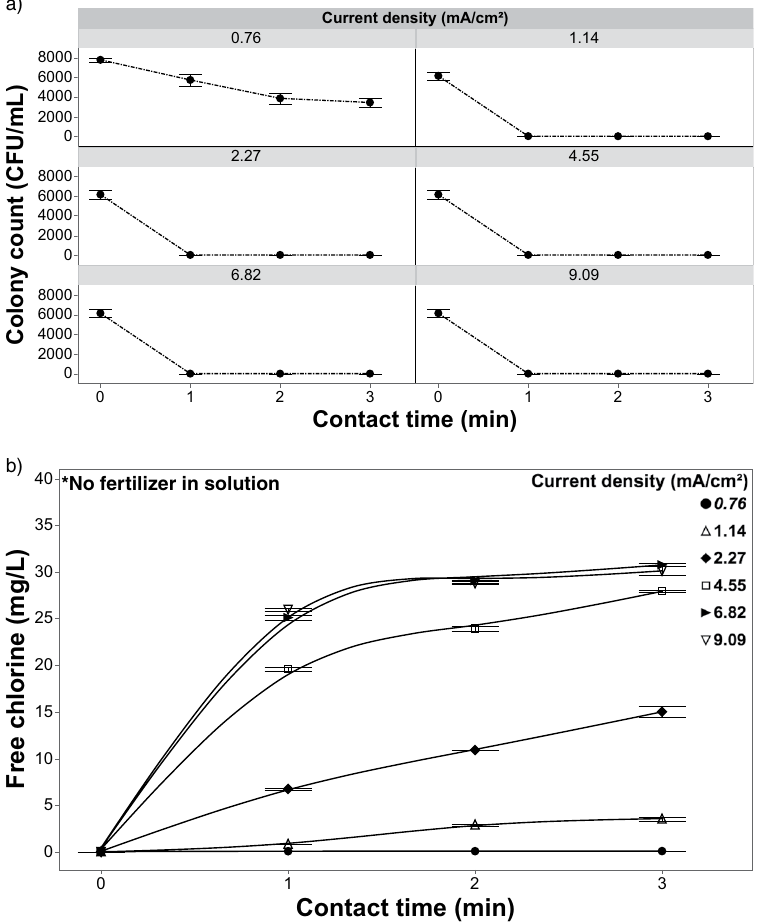
Figure 5. Inactivation and free chlorine dynamics in the absence of fertilizer. ( a ) Inactivation of R. solani as a function of current density and contact time with 20 mg/L of chloride in solution with no fertilizer present, and ( b ) effluent free chlorine concentration from the EFC after treatment of R. solani with 20 mg/L of chloride with no fertilizer present. Error bars are ± SEM, N = 3.